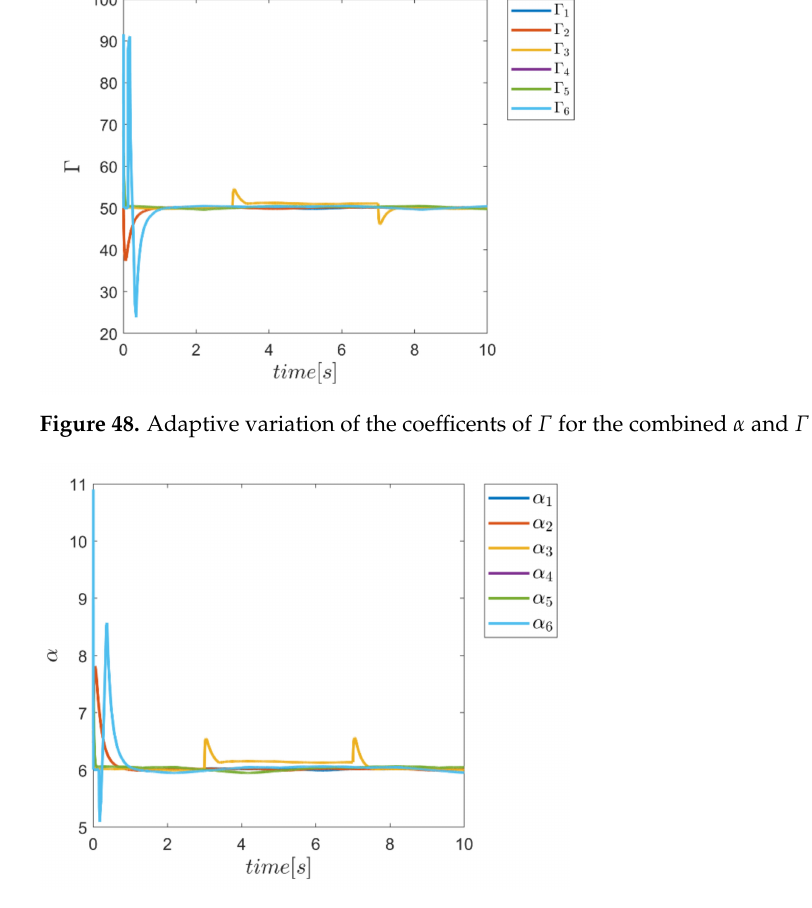
Figure 49. Adaptive variation of the coefficents of α for the combined α and Γ fuzzy system.